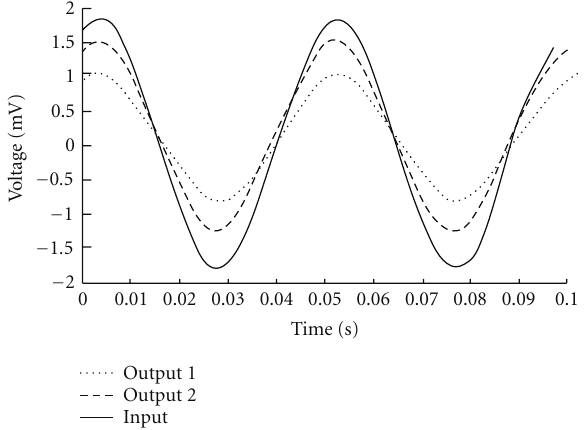
Figure 7: Output signals from the two leaves of the plant for a given sinusoidal input signal of same frequency.